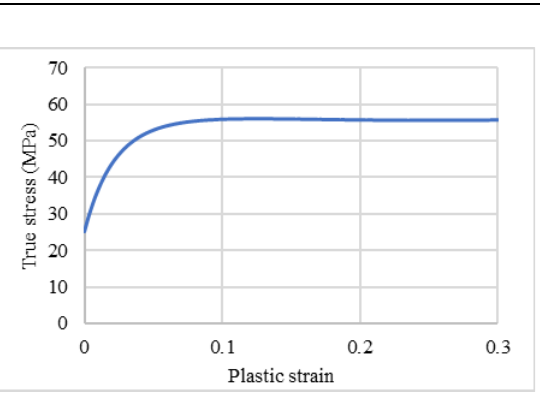
Figure 1. Plastic stress – strain curve of polypropylene at room temperature and strain rate of 10 − 1